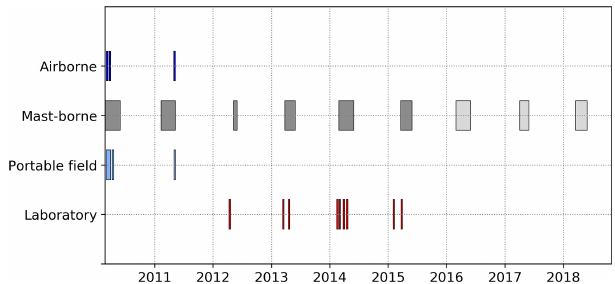
Figure 4. Overlap of the different measurements conducted over different platforms. For the mast-borne platform, the observations first cover a spectral range of 350–2500nm and a range of 350– 1000nm from 2016